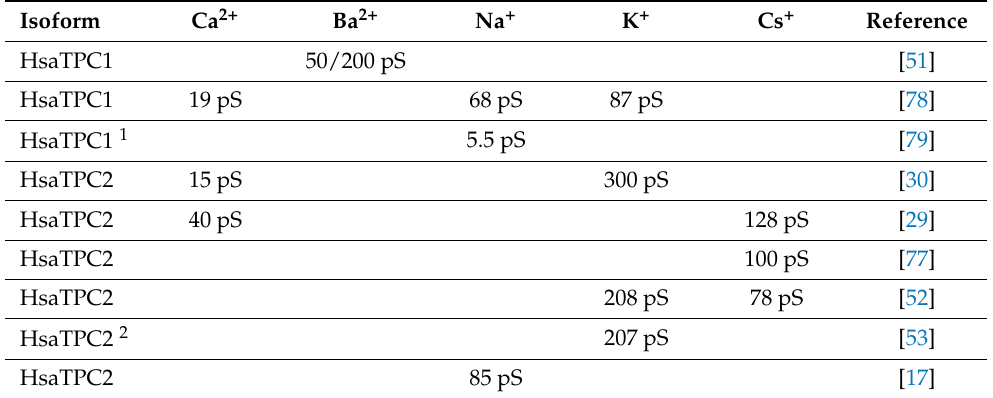
Table 2. Single-channel conductance of TPCs. Data are reported for NAADP or voltage 1 activation, along with 2 endogenous